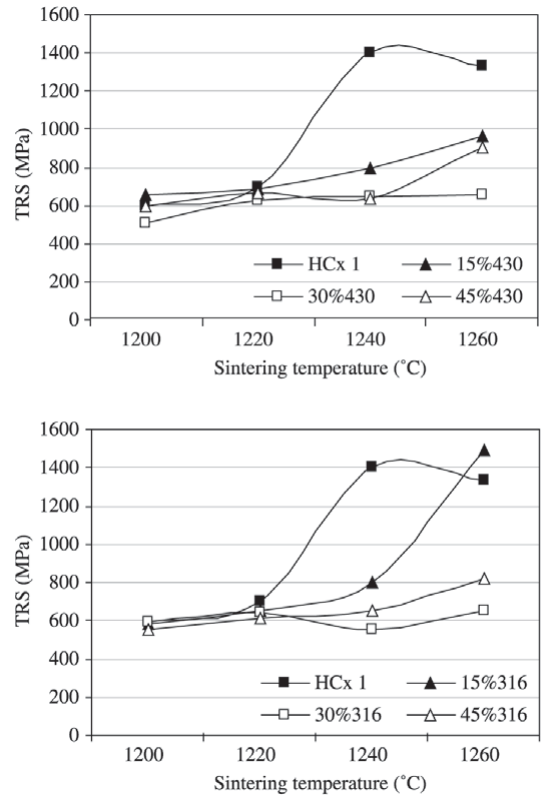
Figure 5. Transverse rupture strength (TRS) of diluted materials vs. sintering